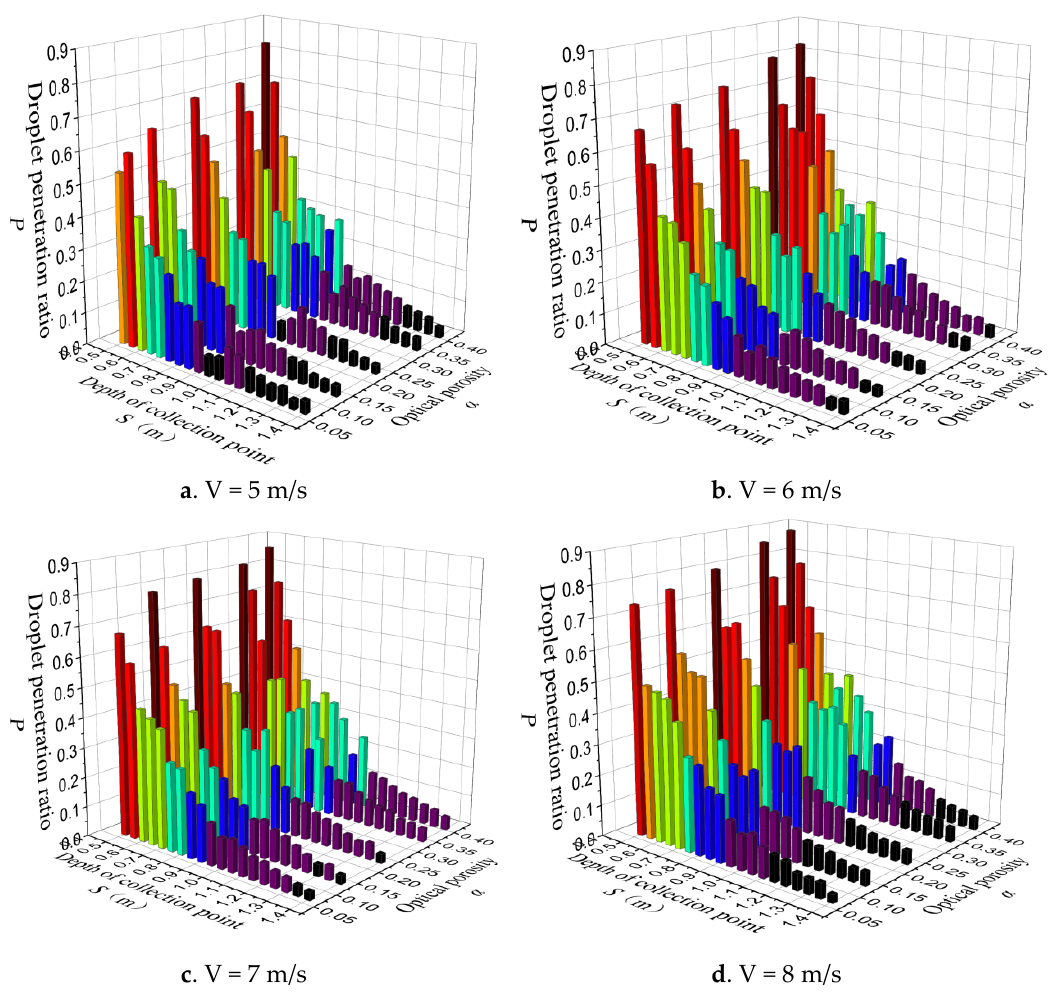
Figure 11. The effects of the incoming wind speed V , optical porosity α and collection point depth S on the droplet penetration ratio P.